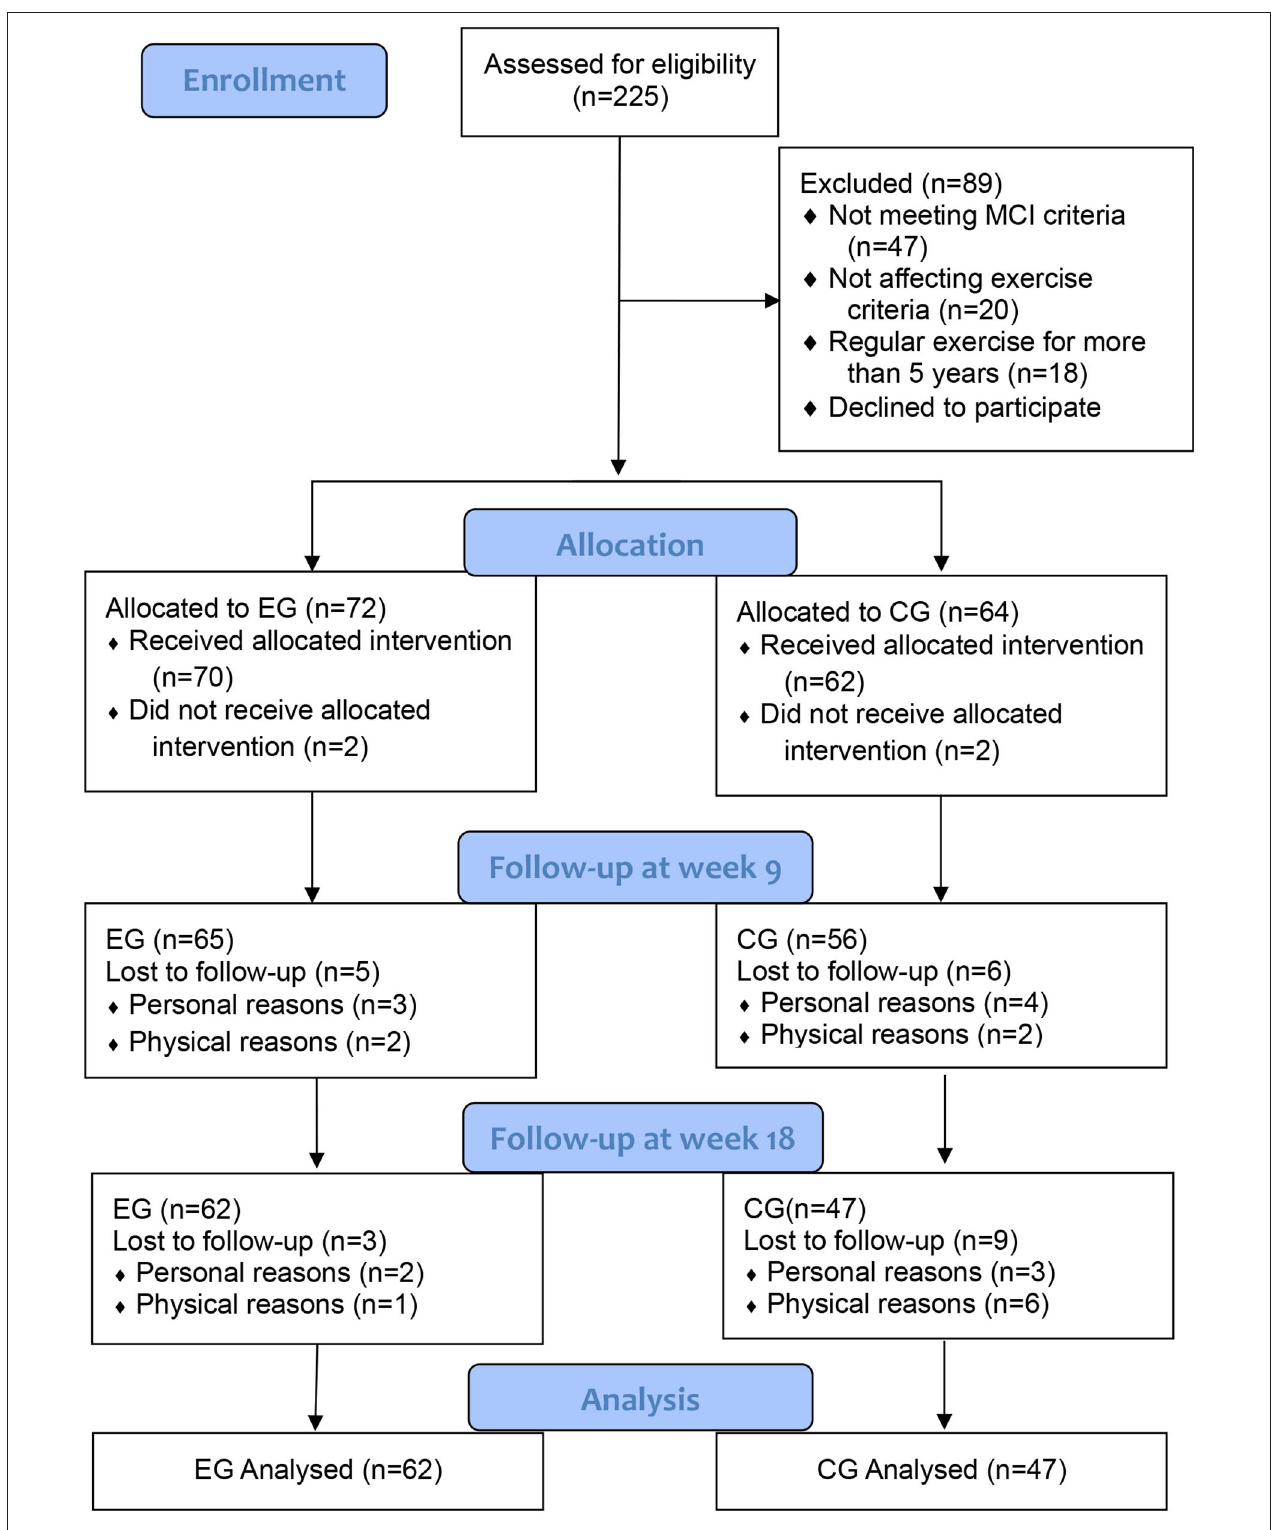
FIGURE 2 | Flowchart of participants recruitment